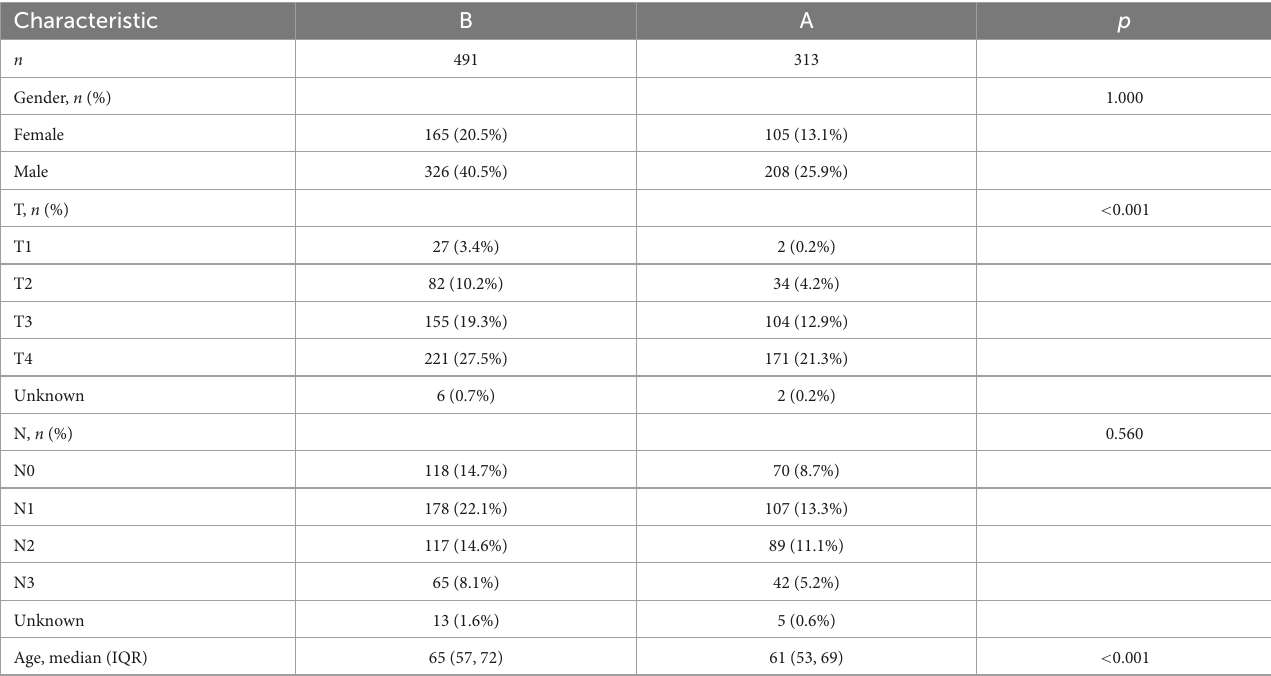
TABLE 1 The chi-square test of the relationship between two subtypes and clinical characteristics.